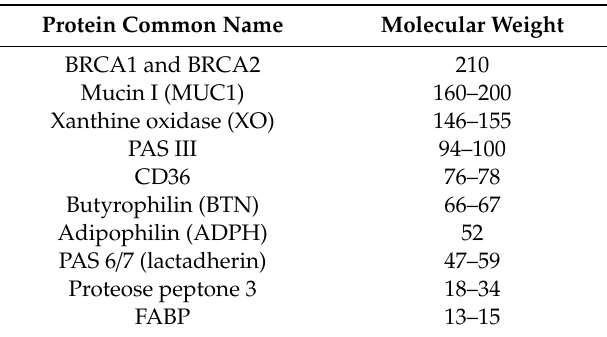
Table 2. Proteins native to the MFGM.